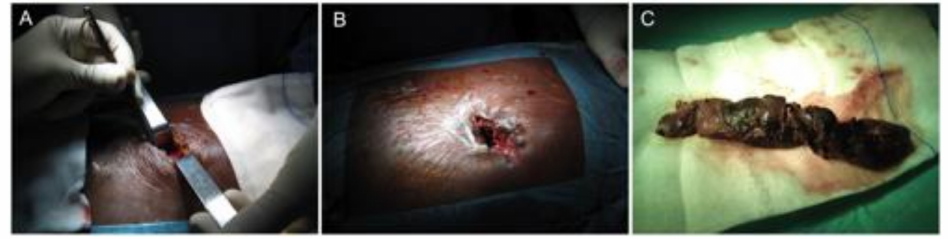
Figure 4. Transperitoneal route. ( A ) Minimally invasive skin incision, ( B ) lesser sac entrance, and ( C ) complete necrosectomy